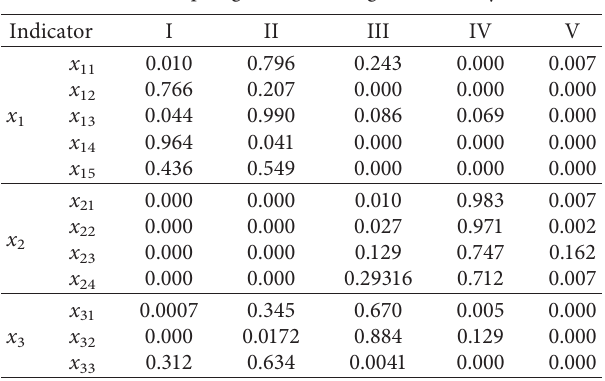
Table 5: Membership degree of building vulnerability